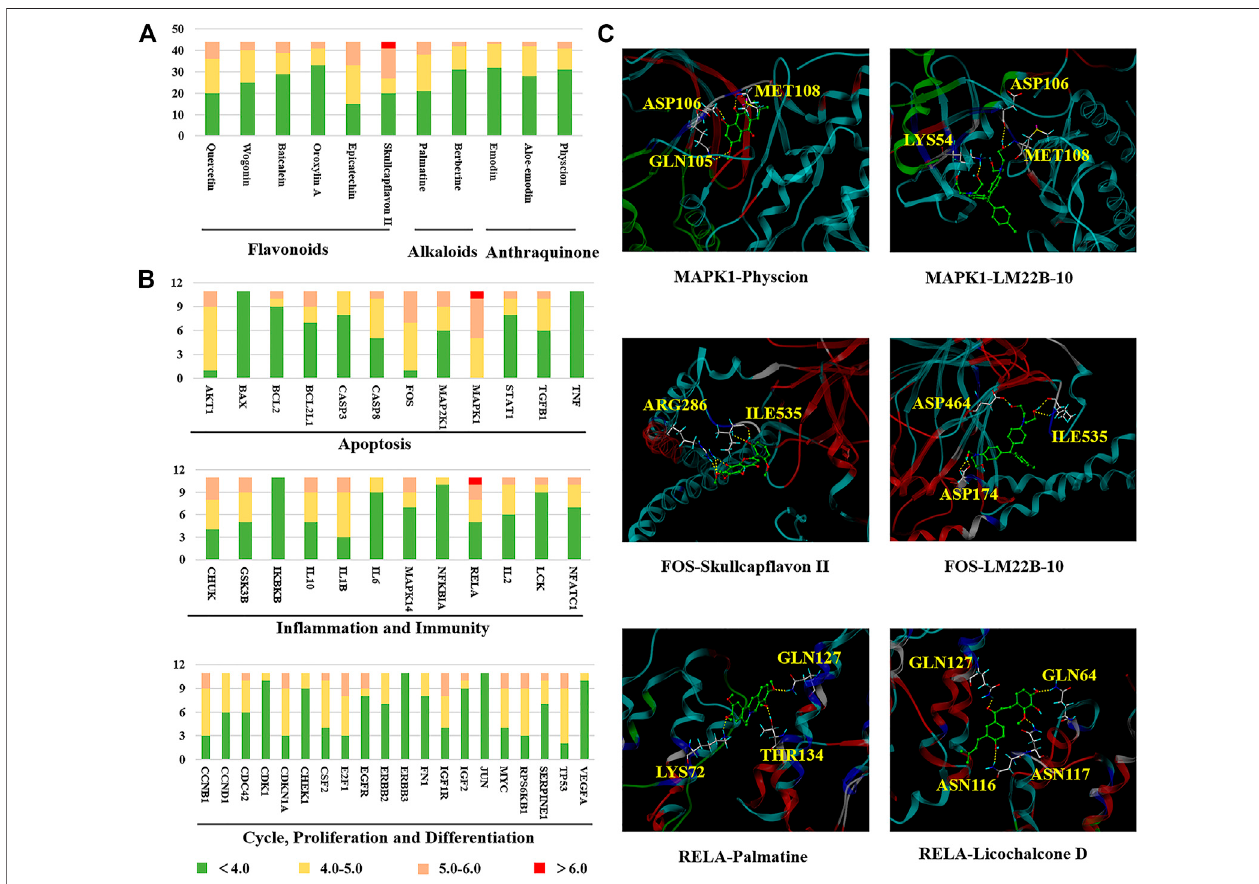
FIGURE 5 | The binding modes of key compounds with related proteins were analyzed by SYBYL-X 2.0 software. (A) Component docking score; (B) Target docking score; (C) Representative docking combinations.